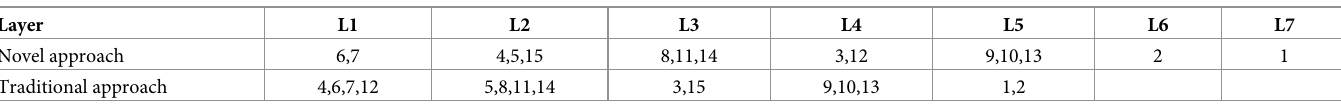
Table 8. Hierarchical structure analysis results of two